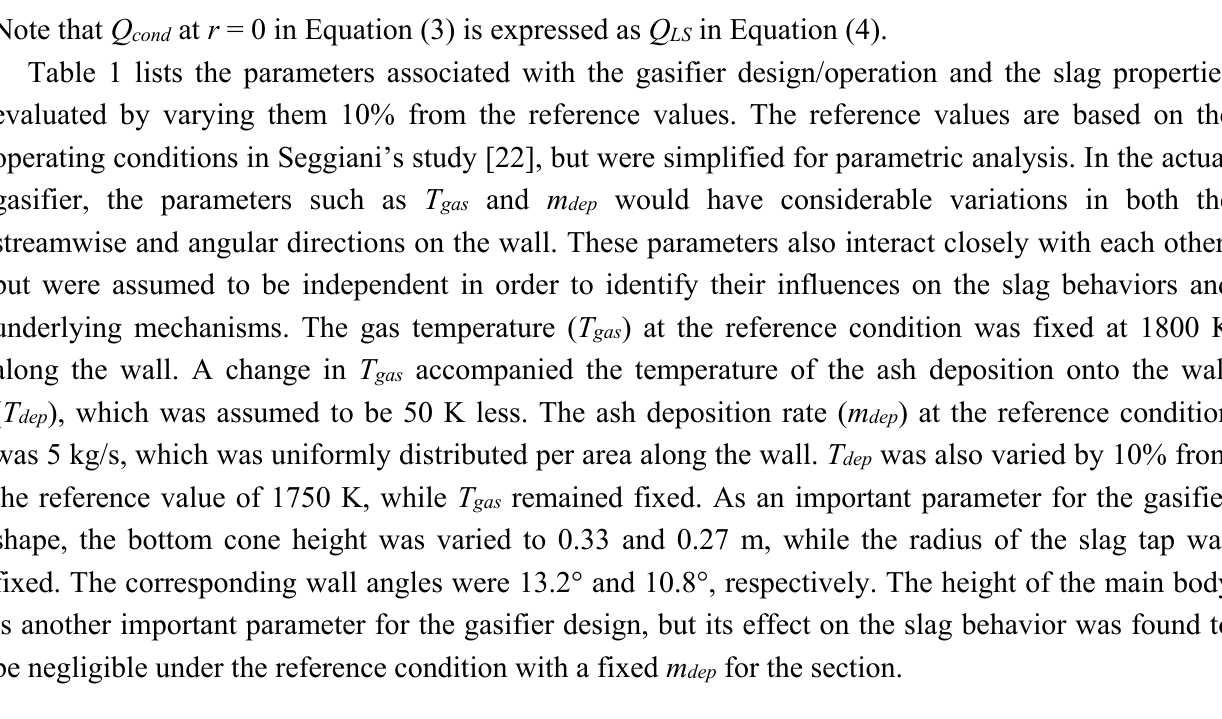
Table 1. Test parameters varied by ±10% for evaluation of their effects on slag